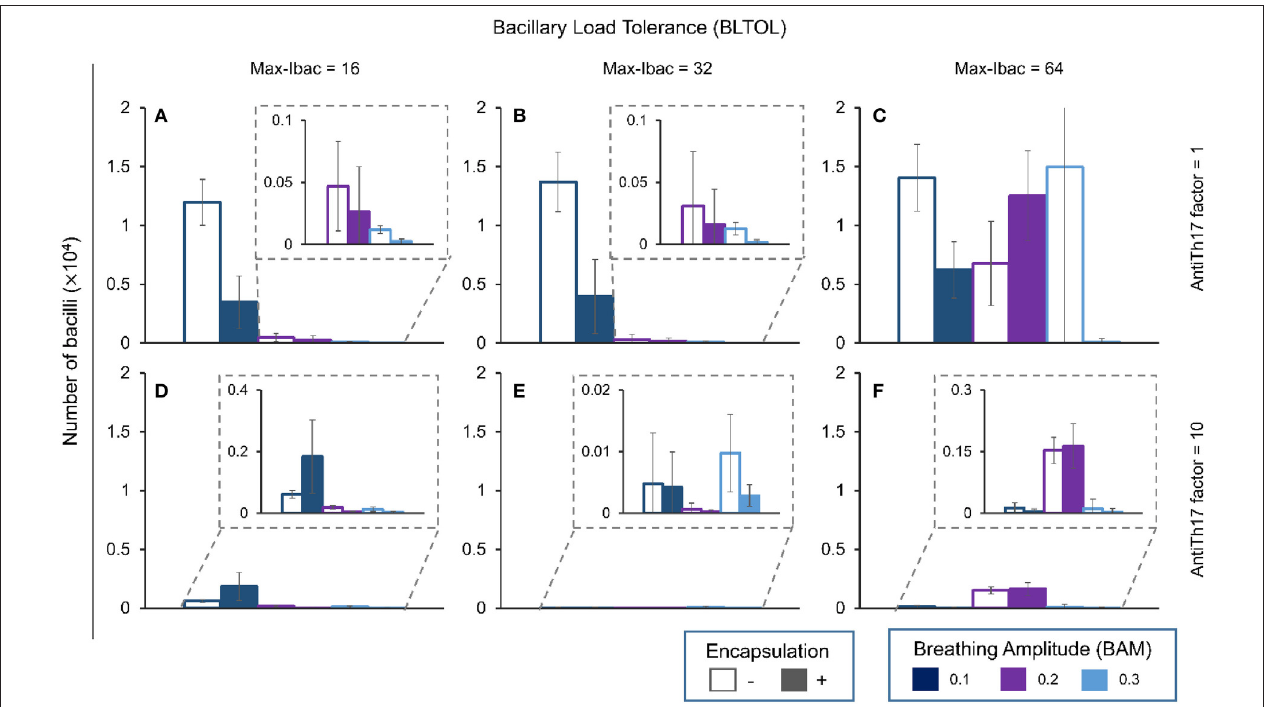
FIGURE 5 | Influence of different parameters on the number of extracellular bacilli at day 42. Maximum bacillary load per macrophage (BLTOL): 16 (A,D) , 32 (B,E) , 64 (C,F) . AntiTh17 factor: 1 (A–C) , 10 (D–F) Encapsulation factor: − , no encapsulation, + , encapsulation. Breathing amplitude (BAM): 0.1, 0.2, 0.3. Bars indicate the mean of 10